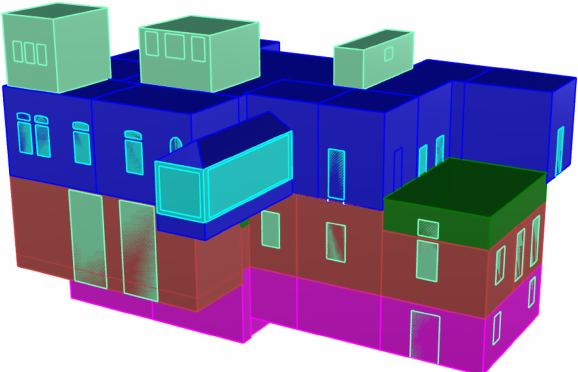
Figure 6. The simplified three-dimensional model of the villa for energy simulation.